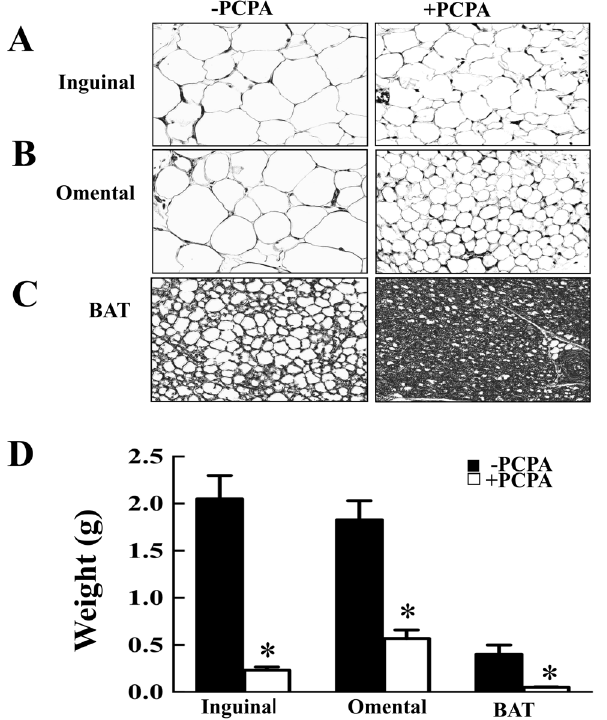
Figure 2. 2-PCPA reduces triglyceride accumulation in white and brown adipose tissues. Mice fed a HFD with or without 2-PCPA for 90 days were sacrificed and adipose tissues were weighed and sectioned for morphologic assessment. (A, B, C) H&E staining of inguinal, omental, and brown adipose tissue sections, respectively. (D) Fresh tissue weights. Bars represent means 6 standard errors of each group (n=5). (*) indicates a statistically significant difference (p , 0.05) between the 2-PCPA treated and non-treated groups.